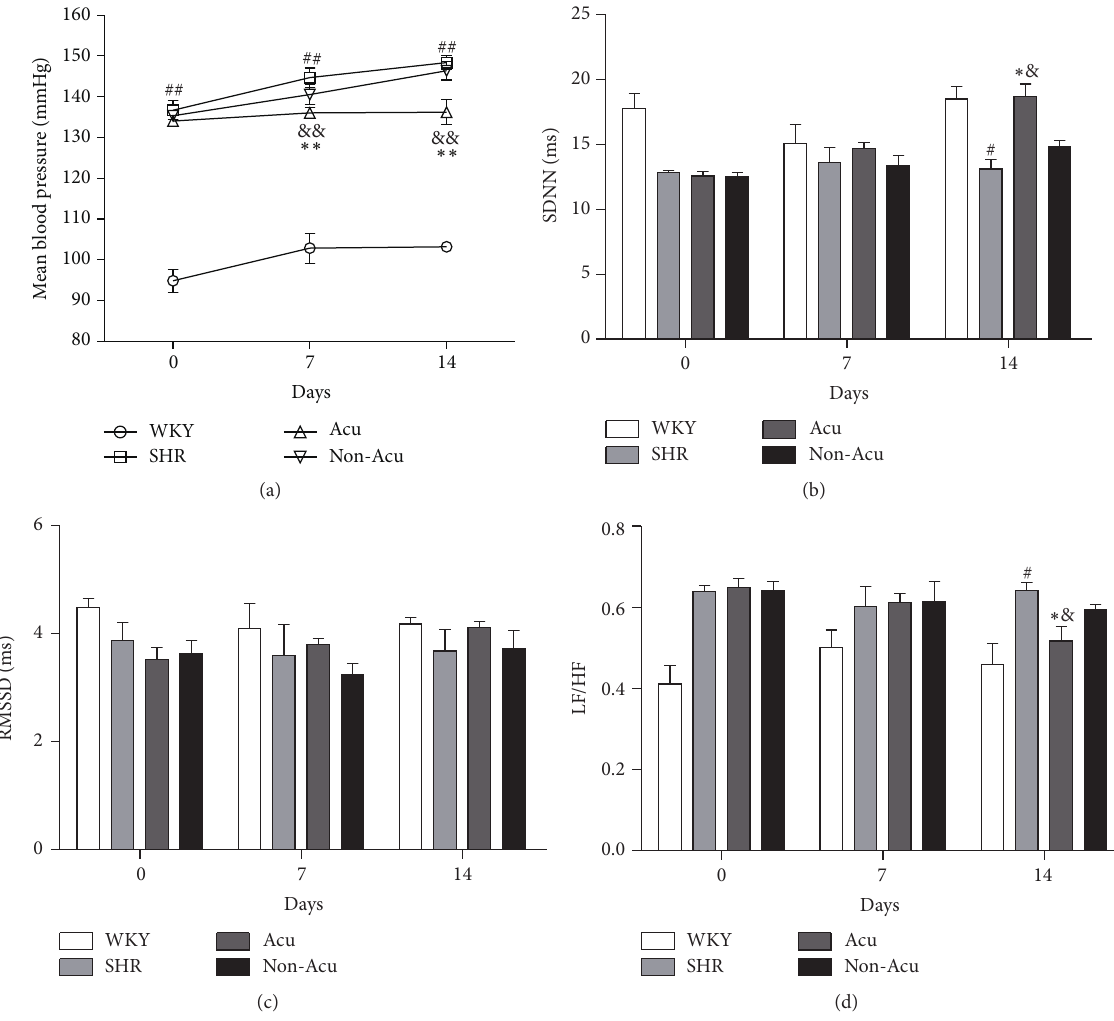
Figure 1: Effects of acupuncture on mean blood pressure (a) and heart rate variability (b–d) as measured by radiotelemetry in all groups. Data are presented as mean ± SEM ( 𝑛 = 10 rats). # and ## indicate 𝑃 < 0.05 and 𝑃 < 0.01 , respectively, compared with the WKY group; ∗ and ∗∗ indicate 𝑃 < 0.05 and 𝑃 < 0.01 , respectively, compared with SHR group; & and && indicate 𝑃 < 0.05 and 𝑃 < 0.01 , respectively, compared with Non-Acu